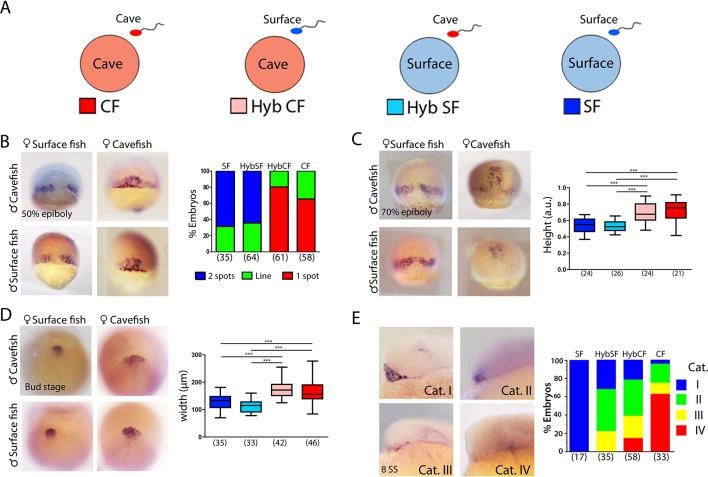
Maternal effect on early development.(A) Schematic representation of the fertilizations performed for the analyses of maternal effect in F1 hybrids. Oocytes from either morph (cave in pink and surface in light blue) were fertilized with sperm from cavefish (red) or surface fish (blue). For simplicity, F1 hybrids were named HybCF (oocyte from cavefish, pink) and HybSF (oocyte from surface fish, light blue), based on their maternal contribution. (B–E) Expression of dkk1b at 50% of epiboly (B), 70% of epiboly (C), bud stage (D) and 8-somite stage (E). (B, right) Quantification of the expression pattern of dkk1b at 50% epiboly, classified into three categories: ‘2 spots’,‘1 spot’ (red), and ‘Line’, which is an intermediate profile (not shown in micrographs). The y-axis indicates the percentage of the total embryos belonging to each of the three categories and the numbers of embryos examined are indicated. (C, right) Quantification of height in dkk1b-labeled embryos at 70% epiboly . (D, right) Quantification of width of the polster based on dkk1b expression. (E, right) Quantification of the pattern of dkk1b at the 8-somite stage, with embryos classified according to the number of positive cells. Category I (blue, surface fish), more than 5 cells; category II (green, HybSF), between 3 and 5 cells; category III (yellow, HybCF); and category IV, no positive cells (red, cavefish). All embryos were imaged in whole mount. Embryos in panels (B) and (C) in dorsal view with the animal pole upwards; embryos in panel (D) are in dorsal view with the anterior upwards; and embryos in panel (E) are in lateral view with the anterior to the left. Kruskal-Wallis tests with Dunn’s post-test were performed in all cases. ***, p = <0.001.